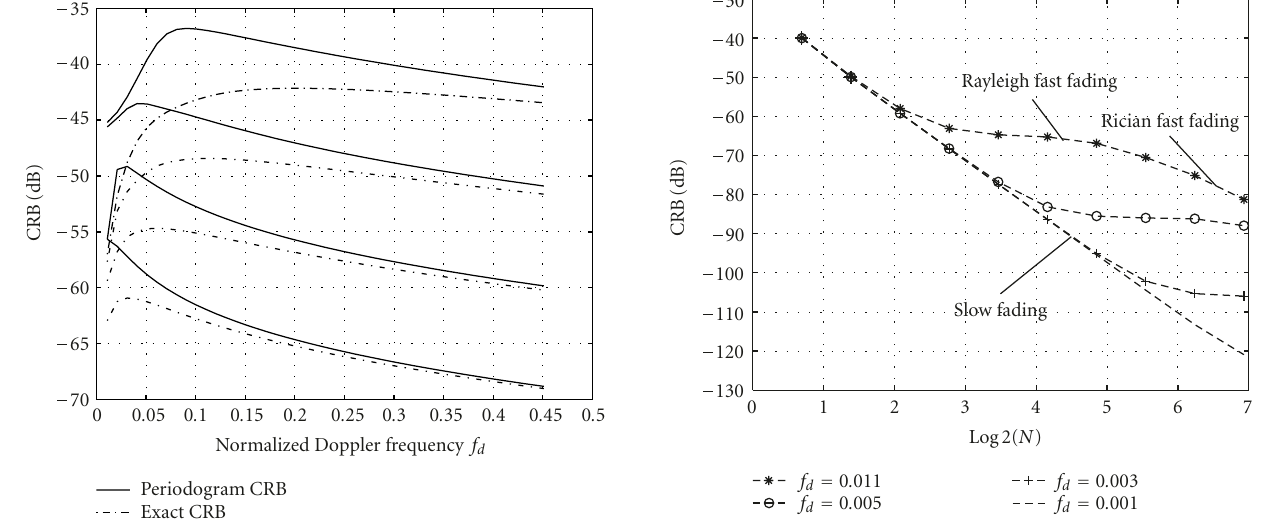
Figure 3: The periodogram-based asymptotic CRB and exact CRB with respect to f d . The results shown are for di ff erent values of N . N = 32,64,128,256, and κ = 4. β = 10dB.